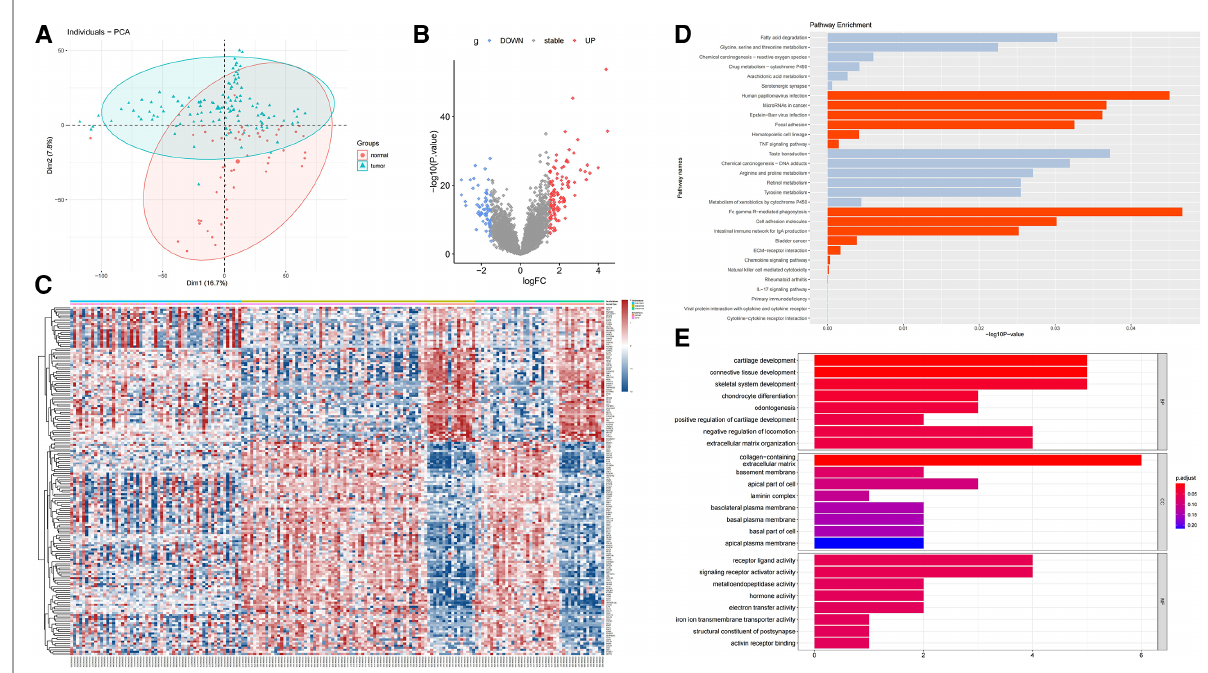
FIGURE 1 Differential expression analysis of the GEO merged data set (GSE13601, GSE34105 and GSE34106). ( A ) PCA analysis was performed to identify differences between tumor tissue and normal tissue in the combined data set. ( B ) Volcano diagram representing the DEGs obtained by differential expression analysis using the limma package, where red represents upregulated DEGs and blue represents downregulated DEGs. ( C ) Heatmap showing the differentially expressed genes in three data sets, with the annotations above representing each data set and the annotations in the second row representing different types of samples. The differentially expressed genes are shown on the right, where red represents upregulated genes and blue represents downregulated genes. ( D ) KEGG pathway enrichment analysis of DEGs, in which red represents the upregulation gene enrichment pathway and gray represents the downregulation gene enrichment pathway. ( E ) GO enrichment analysis of